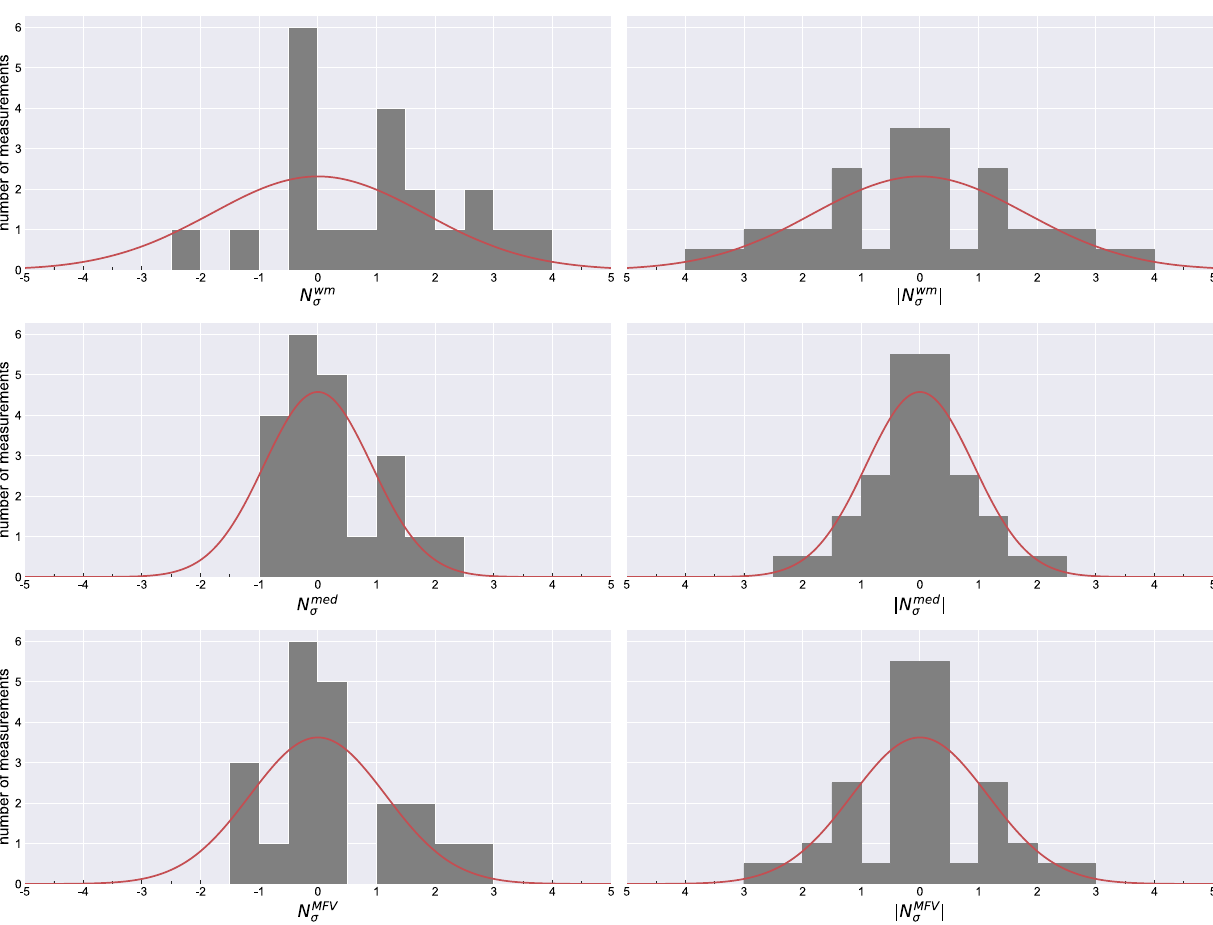
(absolute) deviation, where the smooth curves in panels represent the best-fitGaussian. The N σ ofpositive andnegative casesindicategreater and less than the weighted mean, median, and